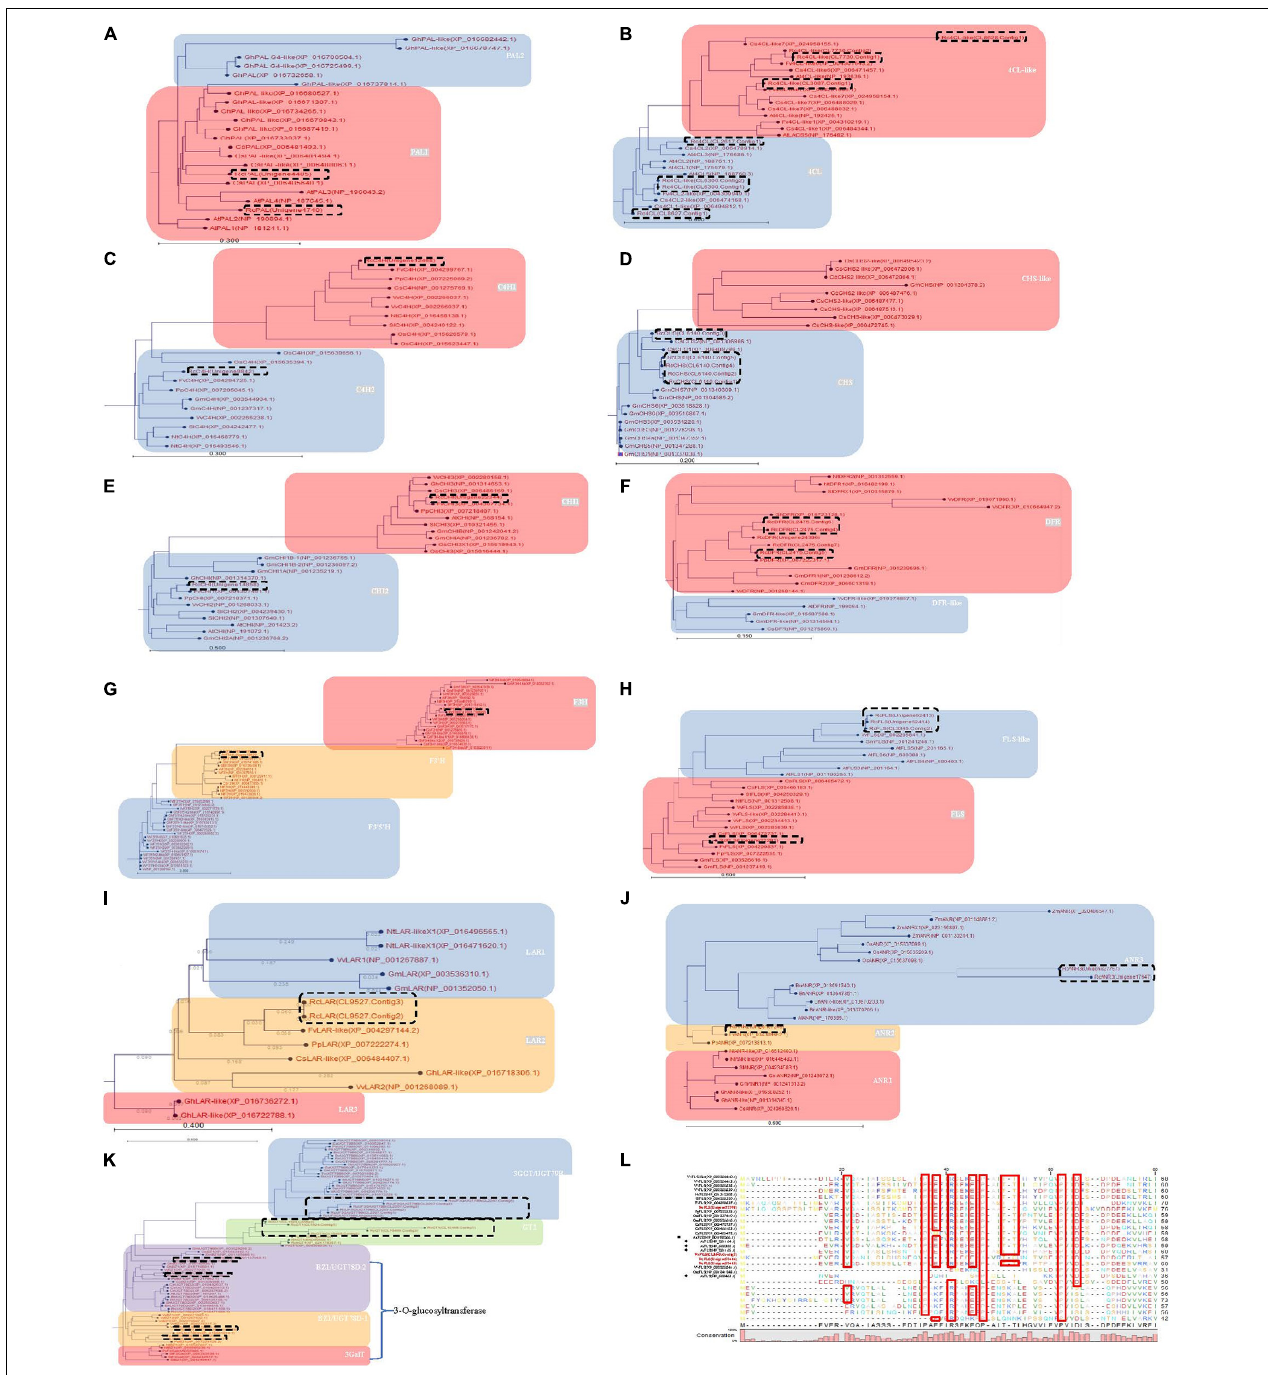
FIGURE 3 | Phylogenetic analysis of the differently expressed genes involved in phenylpropanoid, flavonoid and anthocyanin biosynthesis during four maturation phases in R. chingii . Neighbor-Joining with 1,000 bootstrap replicates was used to construct the phylogenetic tree. The distance between deduced proteins was measured with the “Kimura Protein” method. (A) Phe ammonia lyase (PAL), (B) 4-coumaroyl-CoA synthase (4CL), (C) cinnamate-4-hydroxylase (C4H), (D) chalcone synthase (CHS), (E) chalcone isomerase (CHI), (F) bifunctional dihydroflavonol 4-Reductase/flavanone 4-Reductase (DFR), (G) flavanone-3 β -hydroxylase (F3H), flavonoid-3 (cid:48) -hydroxylase (F3 (cid:48) H), flavonoid-3 (cid:48) ,5 (cid:48) -hydroxylase (F3 (cid:48) 5 (cid:48) H), (H) flavonol synthase (FLS), (I) leucoanthocyanidin reductase (LAR) (J) anthocyanidin reductase (ANR), (K) glucosyltransferase protein. (L) alignment of RcFLS in bold with other functionally characterized plant FLS. The residues framed by red boxes are strictly conserved in the various enzyme subclasses. Arabidopsis AtFLS (NP_001190266.1) marked by squares having strictly conserved residues while AtFLS (NP_201164.1), AtFLS (NP_680388.1), AtFLS (NP_201165.1), and AtFLS (NP_680463.1) are marked by diamonds and has altered or missing conserved residues. Previous studies indicate that only AtFLS1 (NP_001190266.1) encodes a catalytically competent protein and is the only member of this group that influences flavonoid levels (Owens et al., 2015). Genes in dash-line box were from R. chingii. Homologs in gray were down-regulated at the gene/protein level and responsible for the decrease of flavonoids as the fruit matured.